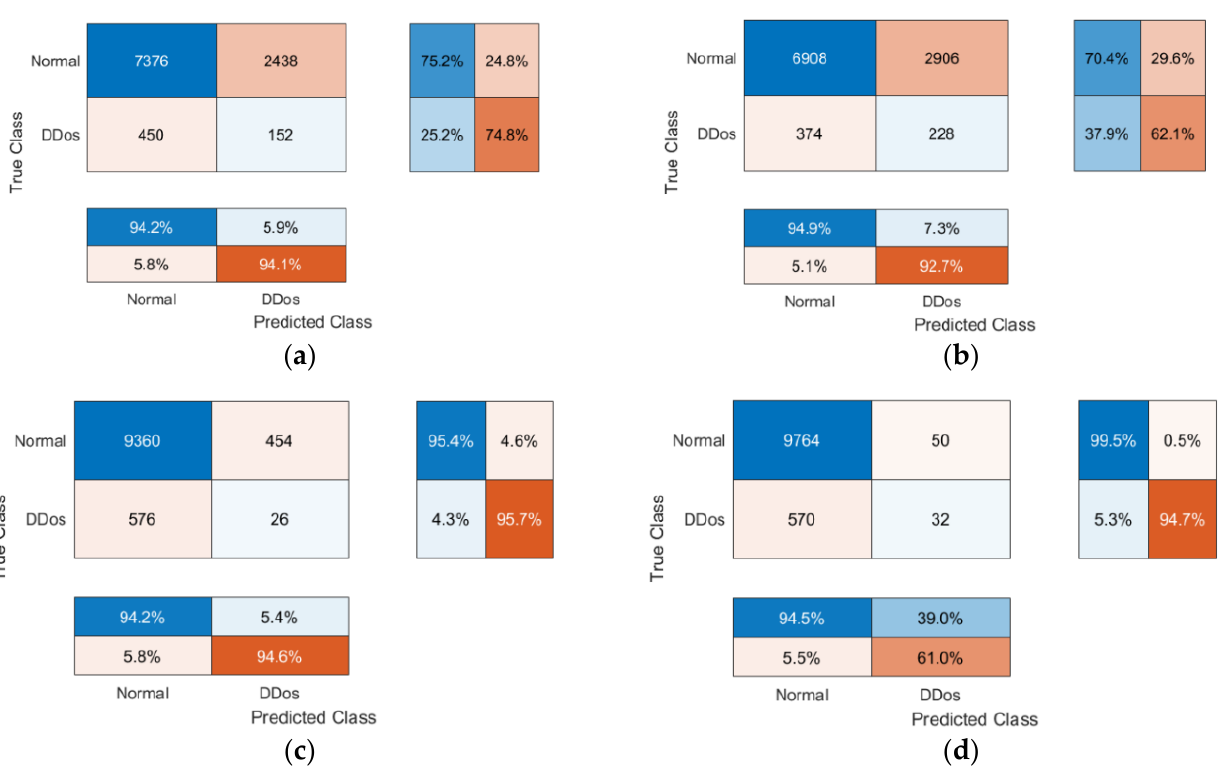
Figure 9. Confusion matrices visualizing the performance of TTL with ResNet50 architecture: ( a ) for local Model1; ( b ) for local Model2; ( c ) for local Model3; ( d ) for local Model4.